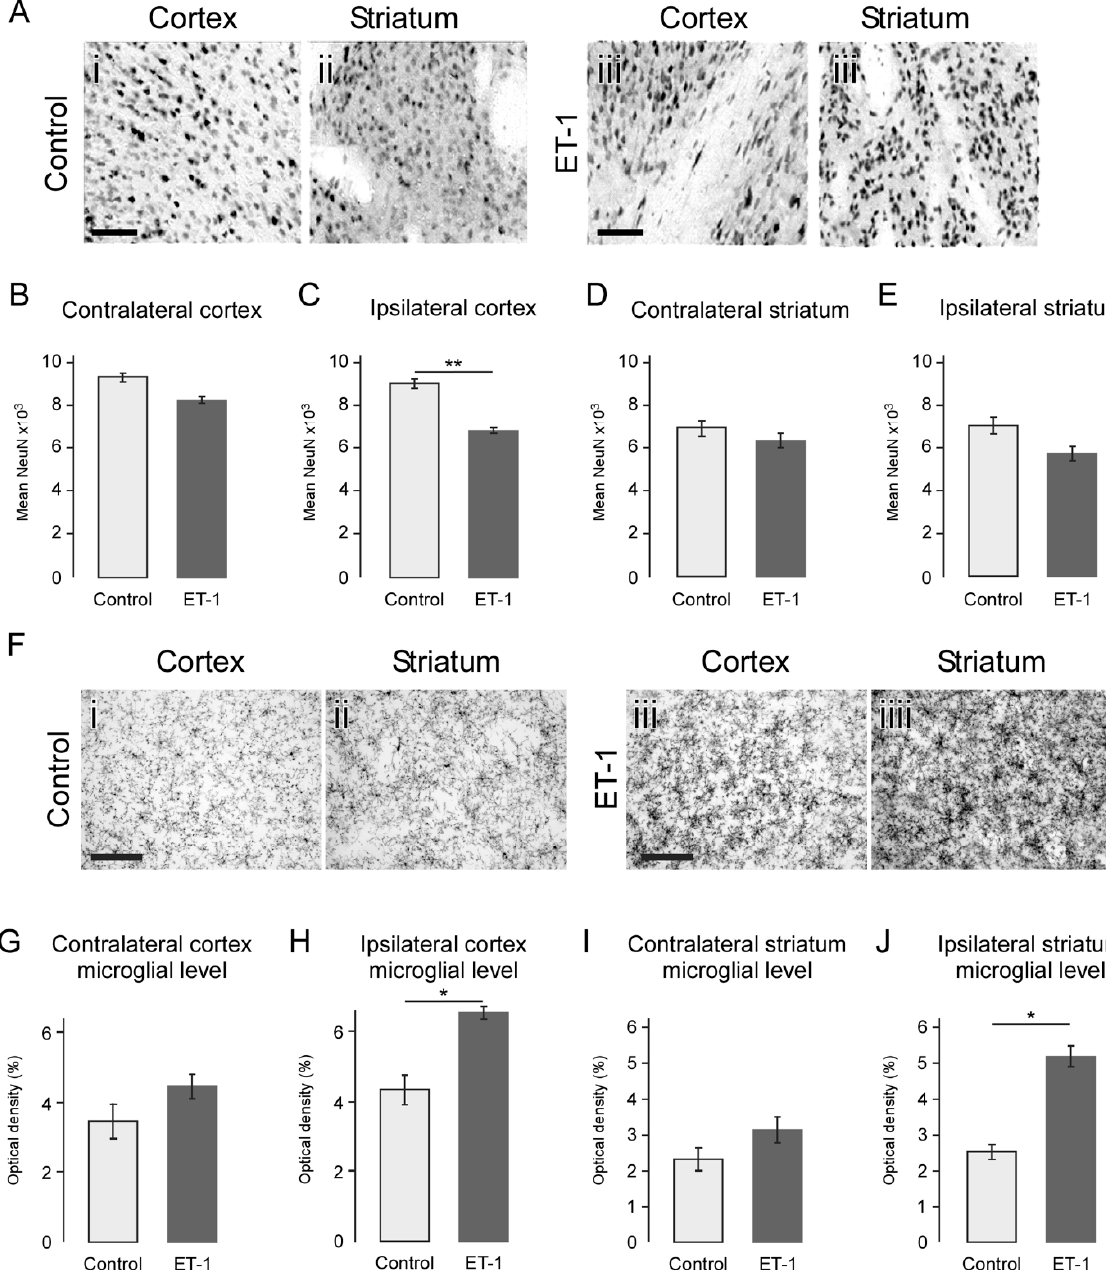
Figure 4. Immunohistochemical assessment of neuronal loss and microglial response to early neonatal ischemic injury. ( A ) Immunohistochemistry for NeuN showing neurons in representative fields of view from cortex and striatum of control and ET-1-treated animals at 24 weeks. Quantification showed that the number of neurons in ET-1 compared to control groups was unchanged in contralateral cortex ( B ) but significantly reduced in the ipsilateral cortex ( C ) and was unchanged in both the contralateral ( D ) and ipsilateral ( E ) striatum. ( F ) Immunohistochemistry for Iba1 showing microglial density in representative fields of view from cortex and striatum of control and ET-1-treated animals at 24 weeks. Quantification showed that microglial density in ET-1 compared to control groups was unchanged in contralateral cortex ( G ) but significantly increased in ipsilateral cortex ( H ) and was also unchanged in contralateral striatum ( I ) and significantly increased in ipsilateral ( J ) striatum. Scale bars: A, C; 100 µm. Error bars = 1 SEM, * p < 0.01, ** p < 0.001, independent t -test, (Group size: Control n = 7; ET-1 lesion n = 17).